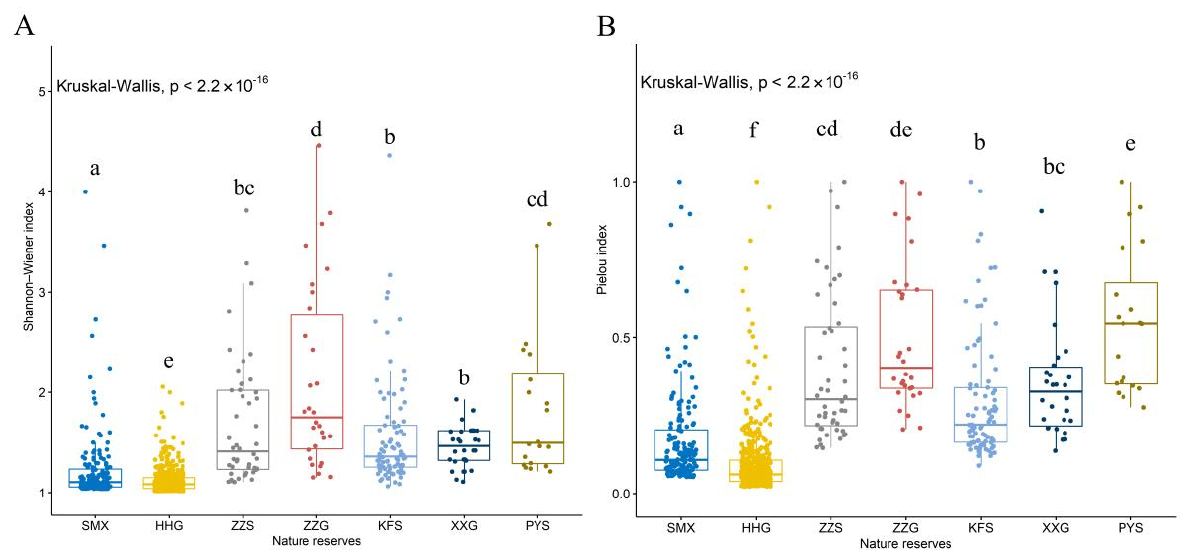
Figure 4. Differences in wetland plant diversity in the seven nature reserves of the Yellow River in Henan Province, China. The number on the black line represents the significance value. Letters are used to distinguish whether there is a significant difference between the protected areas, and different letters indicate that there is a display difference between the protected areas ( p < 0.05). ( A ) Differences in the Shannon–Wiener index of wetland plants in the seven nature reserves; ( B ) Differences in the Pielou index of wetland plants in the seven nature reserves. HHG, Henan Yellow River wetland national nature reserve. SMX, Sanmenxia reservoir area wetland. ZZS, Henan Zhengzhou Yellow River wetland provincial nature reserve. ZZG, Henan Zhengzhou Yellow River national wetland park. KFS, Henan Kaifeng Liuyuankou wetland provincial nature reserve. XXN, Henan Xinxiang Yellow River wetland birds national nature reserve. PYS, Henan Puyang Yellow River wetland provincial nature reserve.